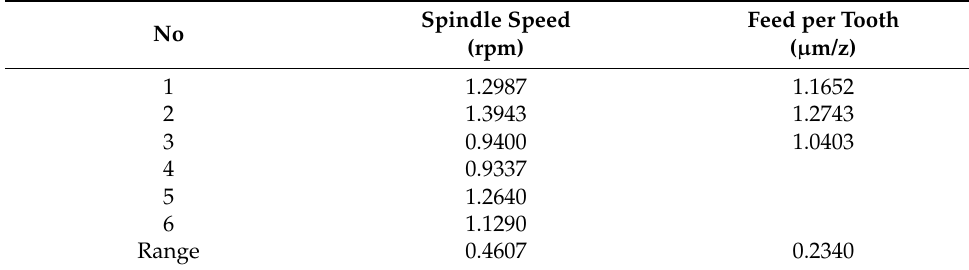
Table 4. The average responses of the surface roughness of sidewall.